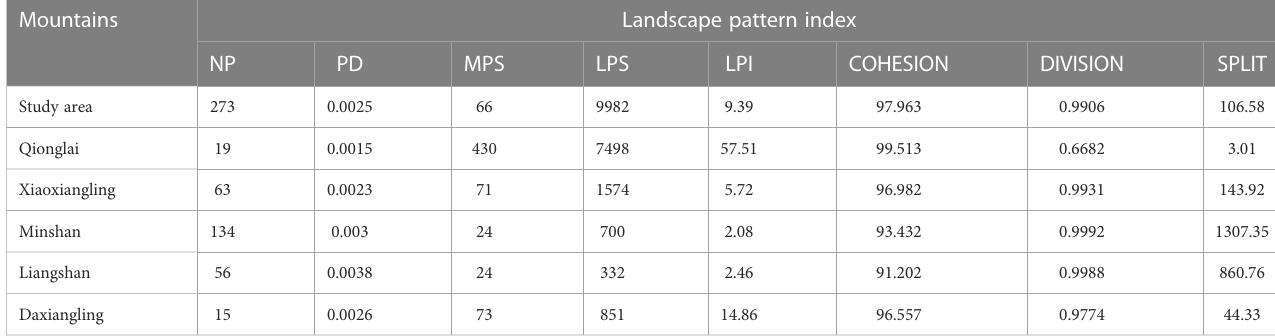
TABLE 2 Analysis of sambar habitat landscape pattern. Mountains